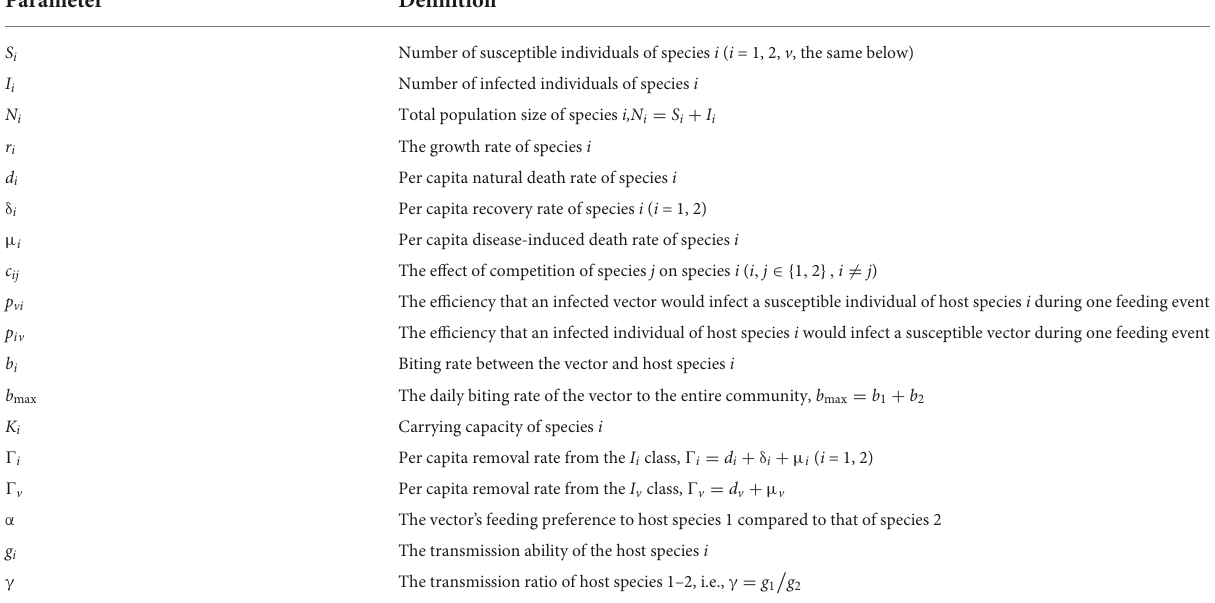
TABLE 1 Parameters and